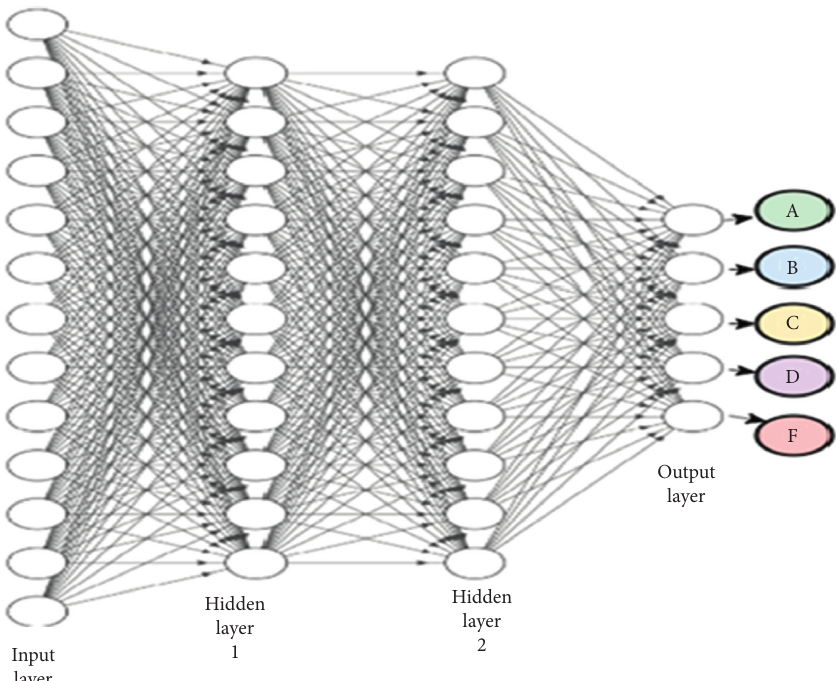
Figure 4: Artificial neural network-based M-learning model with 2 hidden layers, 1 input layer, and 1 output layer.